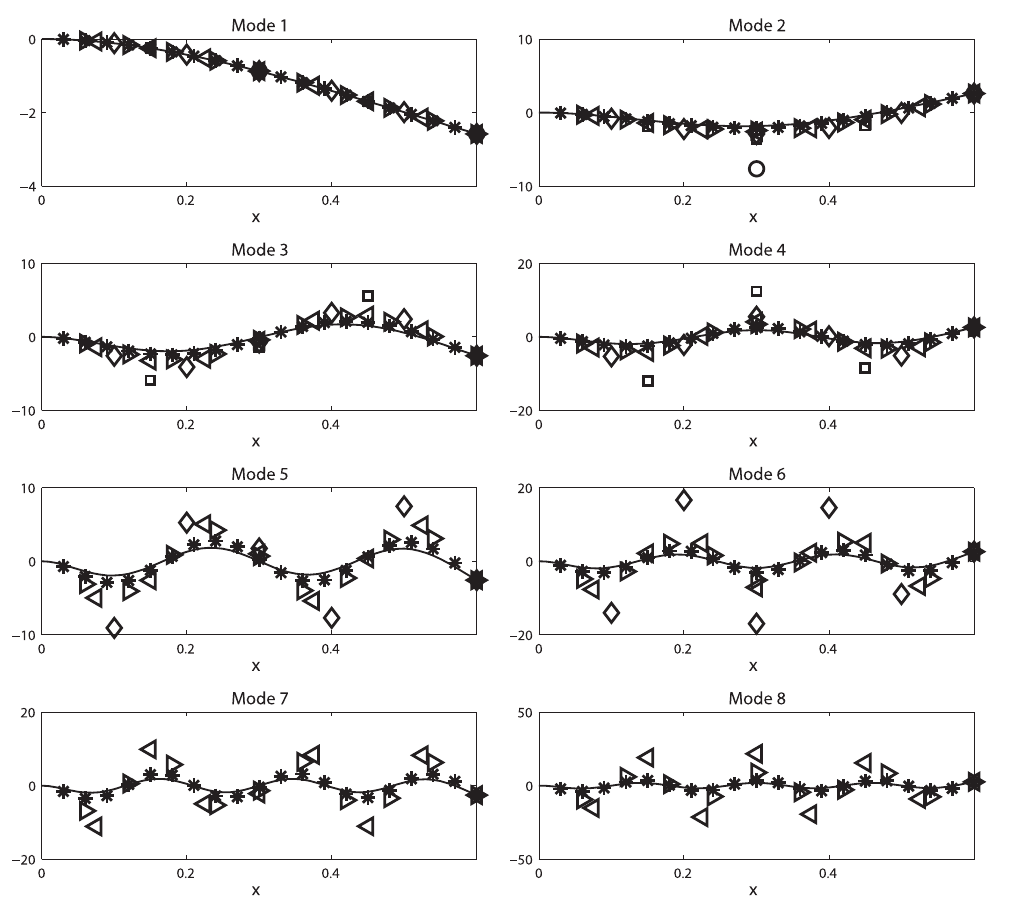
Fig. 2. The modal functions (solid line) and the KLMs with N s = 2 ( ◦ ), N s = 4 ( (cid:4) ), N s = 6 ( (cid:5) ), N s = 8 ( (cid:3) ), N s = 10 ( (cid:4) ) and N s = 20 ( ∗ ).